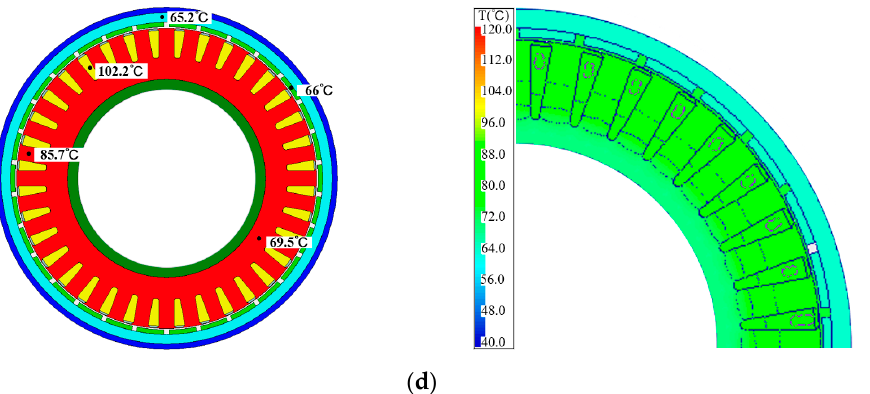
Figure 16. Temperature distribution under four design schemes: ( a ) Case 1; ( b ) Case 2; ( c ) Case 3; ( d ) Case 4.